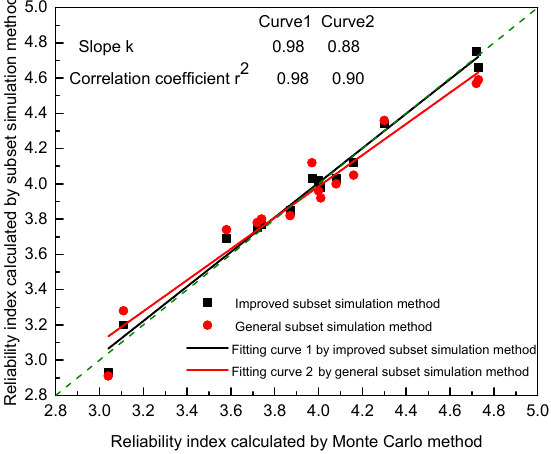
Figure 12. Contrast analysis of the calculation errors of the methods.